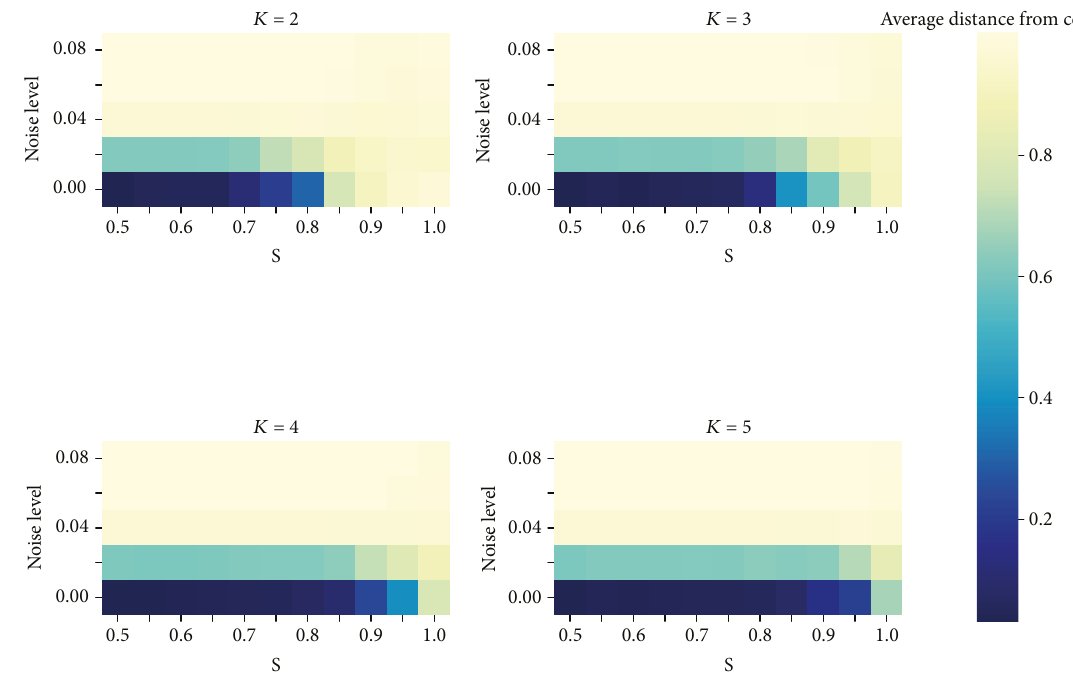
Figure 13: Noisy communication causes extremism without polarization before it causes extremism with polarization. For all K pictured, the average distance from center increases with moderate levels of noise, even though polarization has not increased, as shown in Figure 11. The value in each square of the heat map is the average of 100